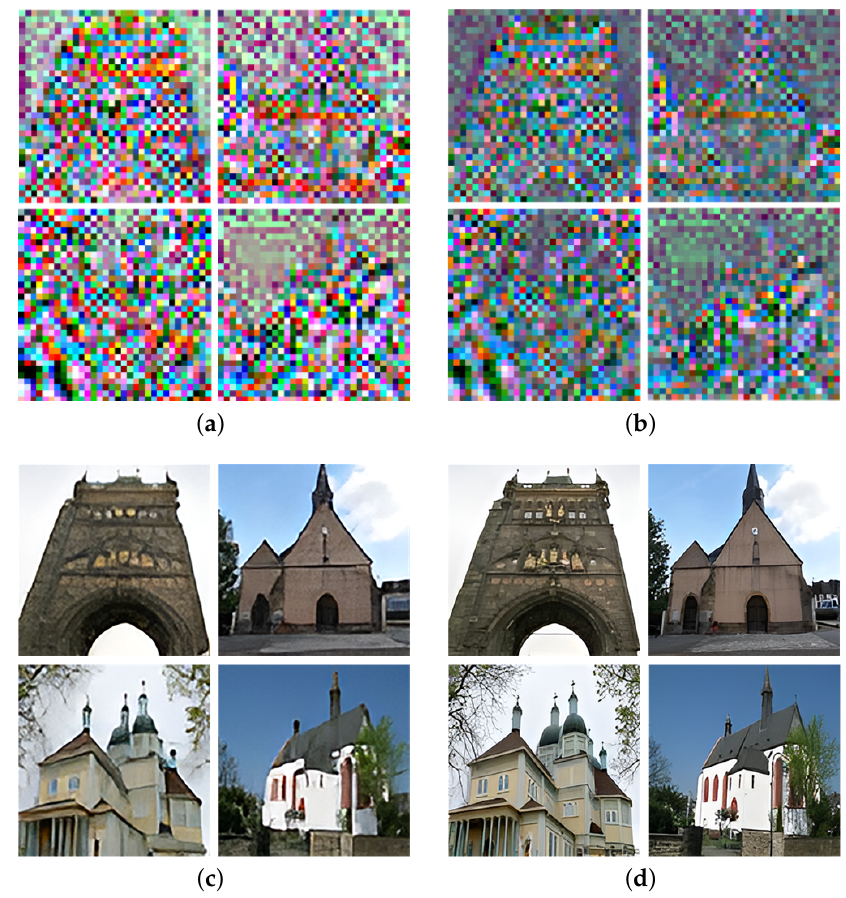
Figure 4. Results of LSUN using L 1 regular term. ( a ) High-frequency features without L 1 regular term; ( b ) High-frequency features with L 1 regular term; ( c ) Deblur images without L 1 regular term; ( d ) Deblur images with L 1 regular